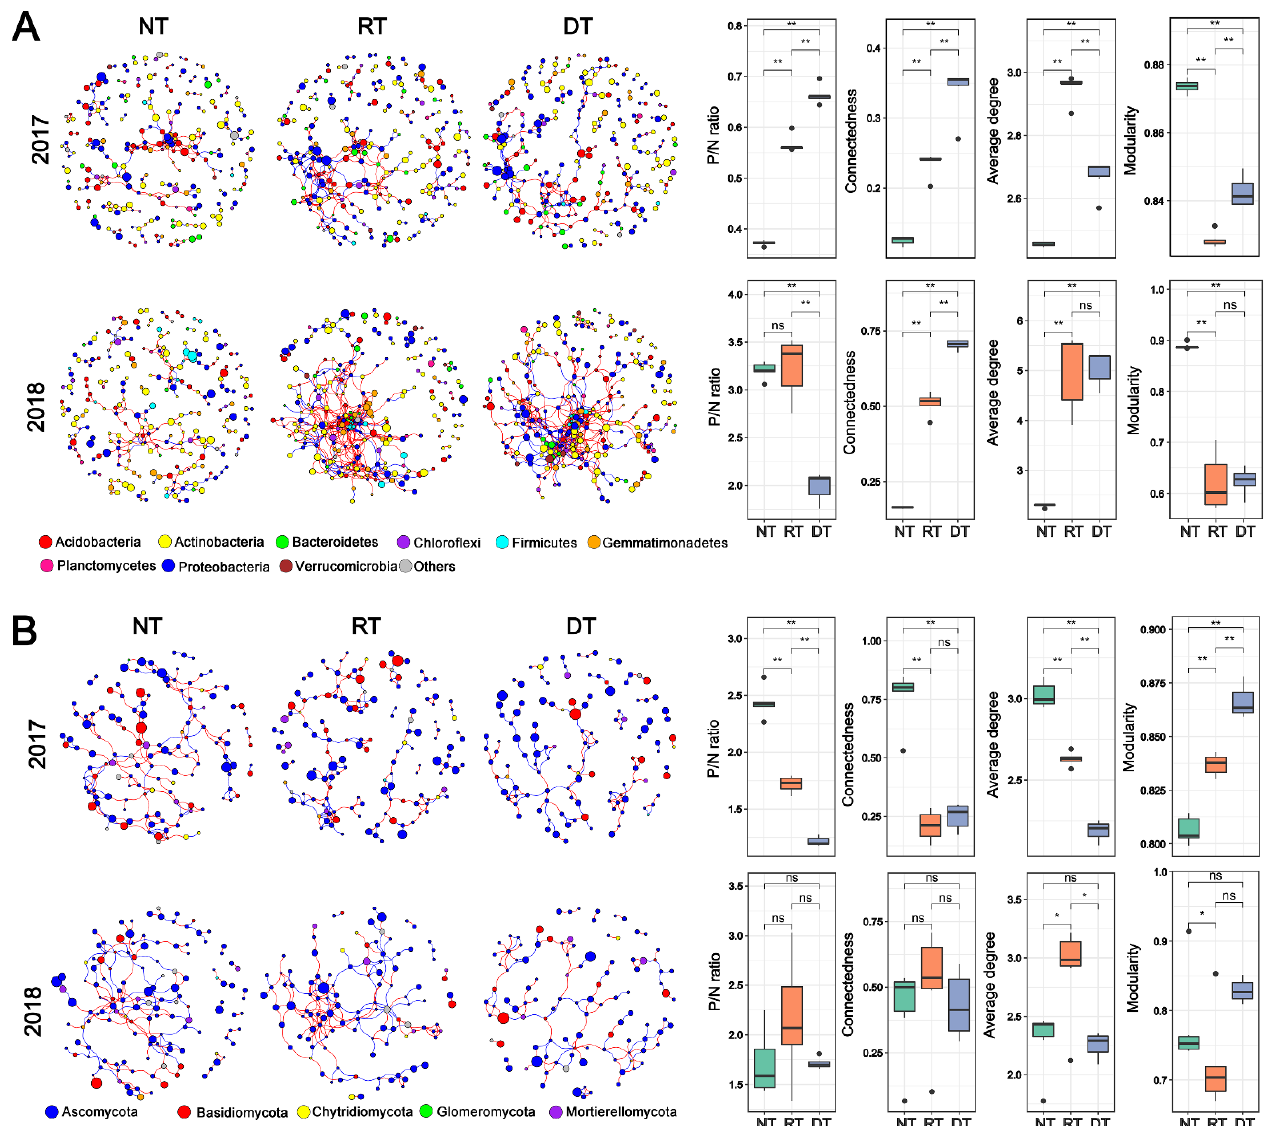
Figure 5. Co-occurrence networks of soil bacterial and fungal communities among treatments ( A ) positive links/negative links (P/N), average degree, connectedness and modularity of bacterial and fungal networks among treatments. ( B ) The red and blue lines indicate positive and negative connections between the nodes, respectively. The size of each circle represents the relative abundance of each node. Asterisk indicate significant difference between treatments (** p < 0.01; * p < 0.05) and ns indicate according to Tukey-HSD test. Abbreviations: NT, no tillage; RT, rotary tillage; DT, deep tillage; ns, non-significant